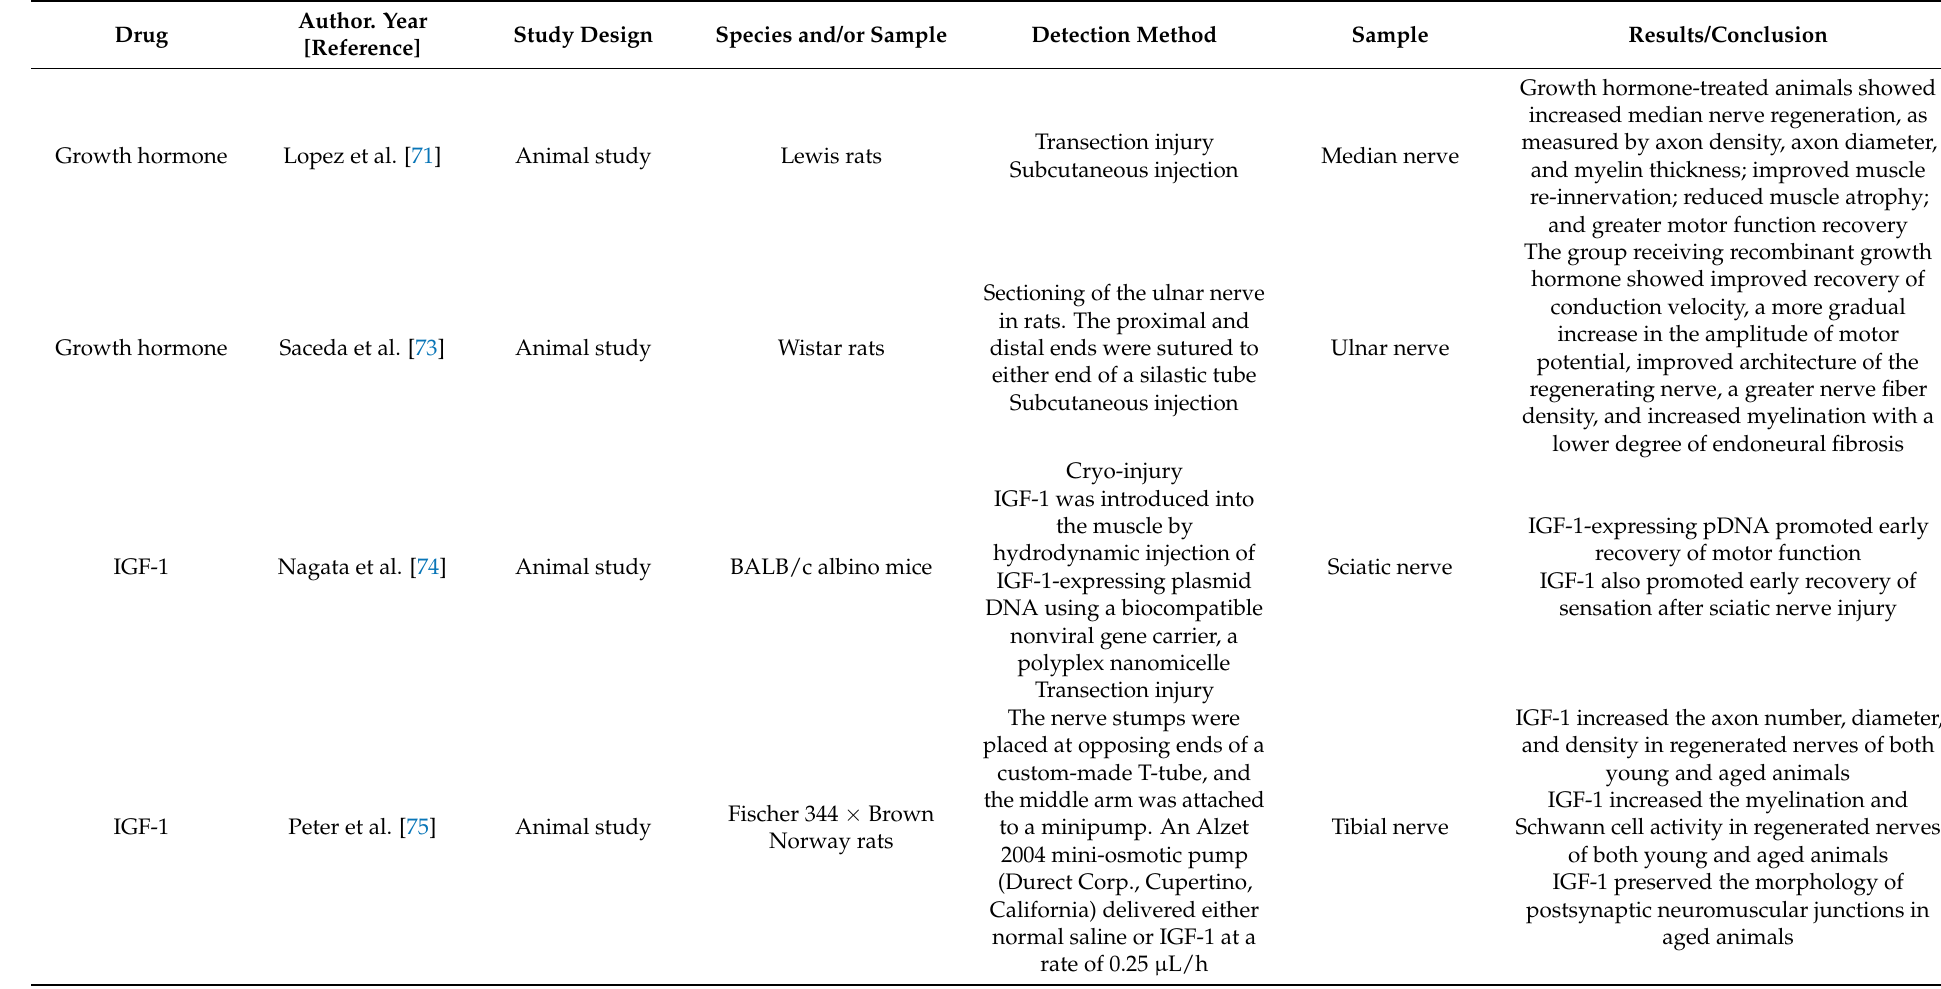
Table 5. Summary of studies that assessed the use of growth hormones for the treatment of peripheral nerve